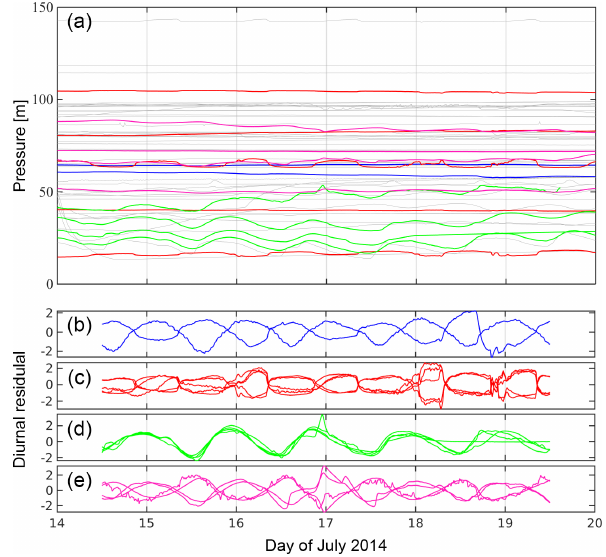
Figure 3. (a) Raw water pressure records of 60 time series over a 6d window starting on 14 July 2014. Time series belonging to four manually identified clusters are shown with thick lines. (b–e) Diur- nal residuals of the sensors belonging to each of the four identified clusters (same colour coding as panel a ). Diurnal residuals are nor- malized by their standard deviation, resulting in a dimensionless